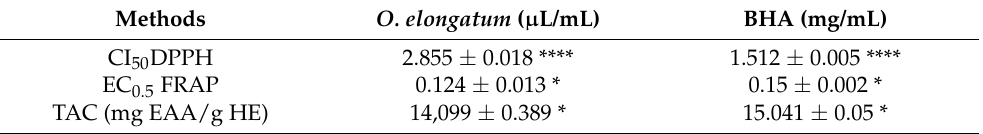
Table 2. Antioxidant activity of the EO of O. elongatum and BHA (Butylated_hydroxyanisole) mea- sured by DPPH, FRAP and TCA methods.